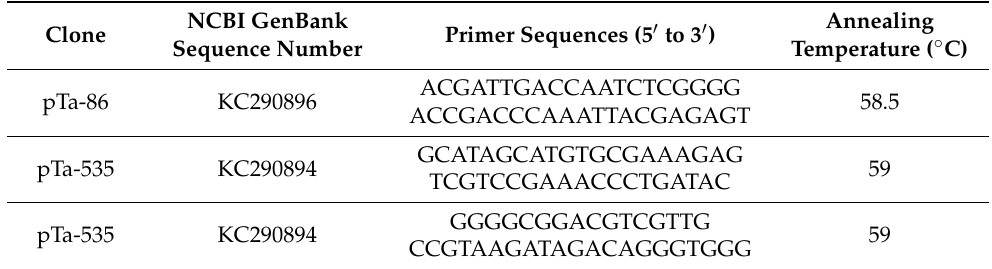
Table 2. Primer sequence and PCR terms for amplification of wheat repetitive sequences [29,30].